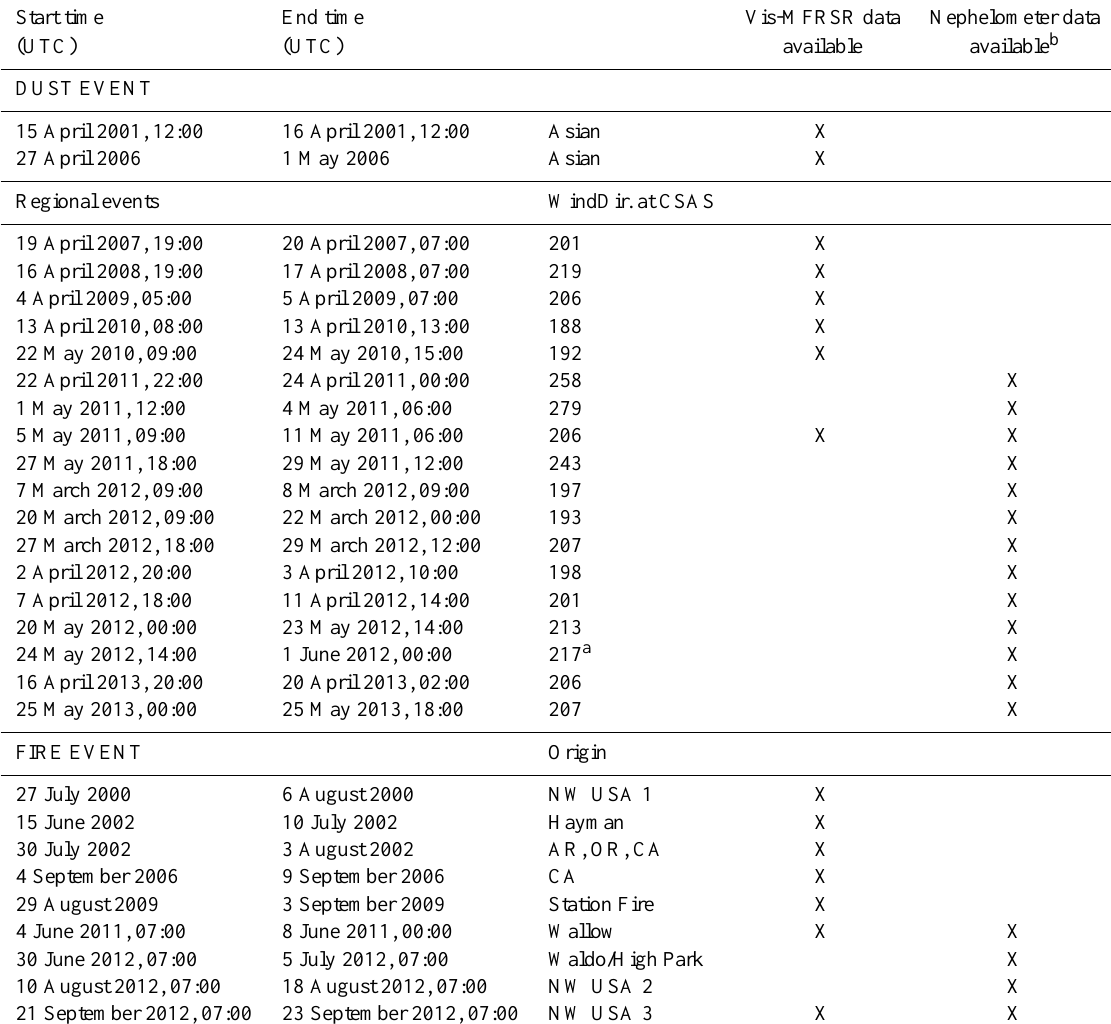
Table 1. Dust and biomass-burning events observed at